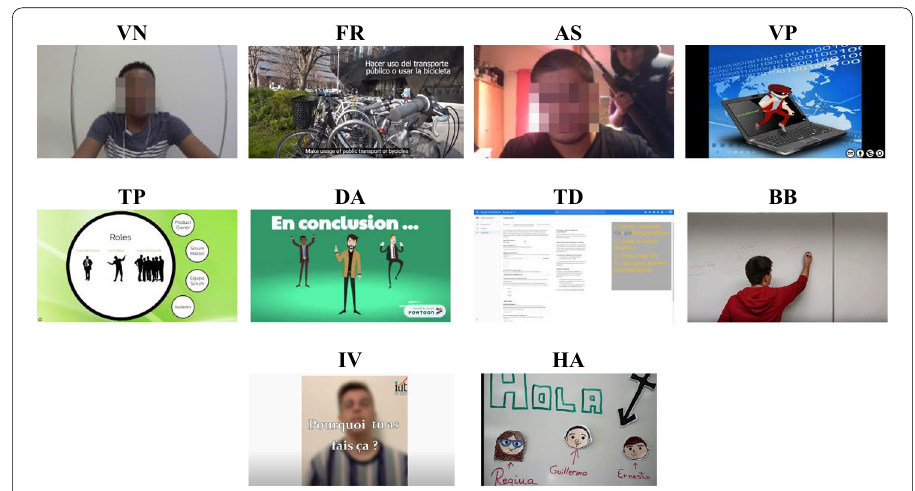
Fig. 1 Illustrative images for each video style in our